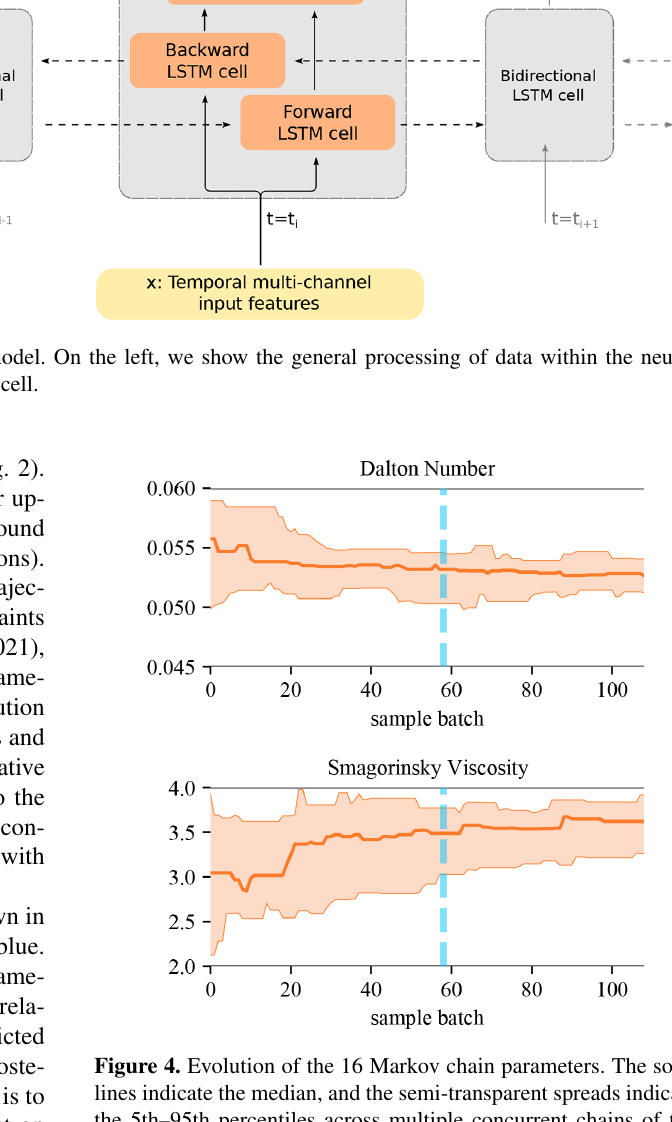
Figure 4. Evolution of the 16 Markov chain parameters. The solid lines indicate the median, and the semi-transparent spreads indicate the 5th–95th percentiles across multiple concurrent chains of the sampler. The vertical dashed blue line indicates the end of the spec- ified burn-in period used to determine the posterior